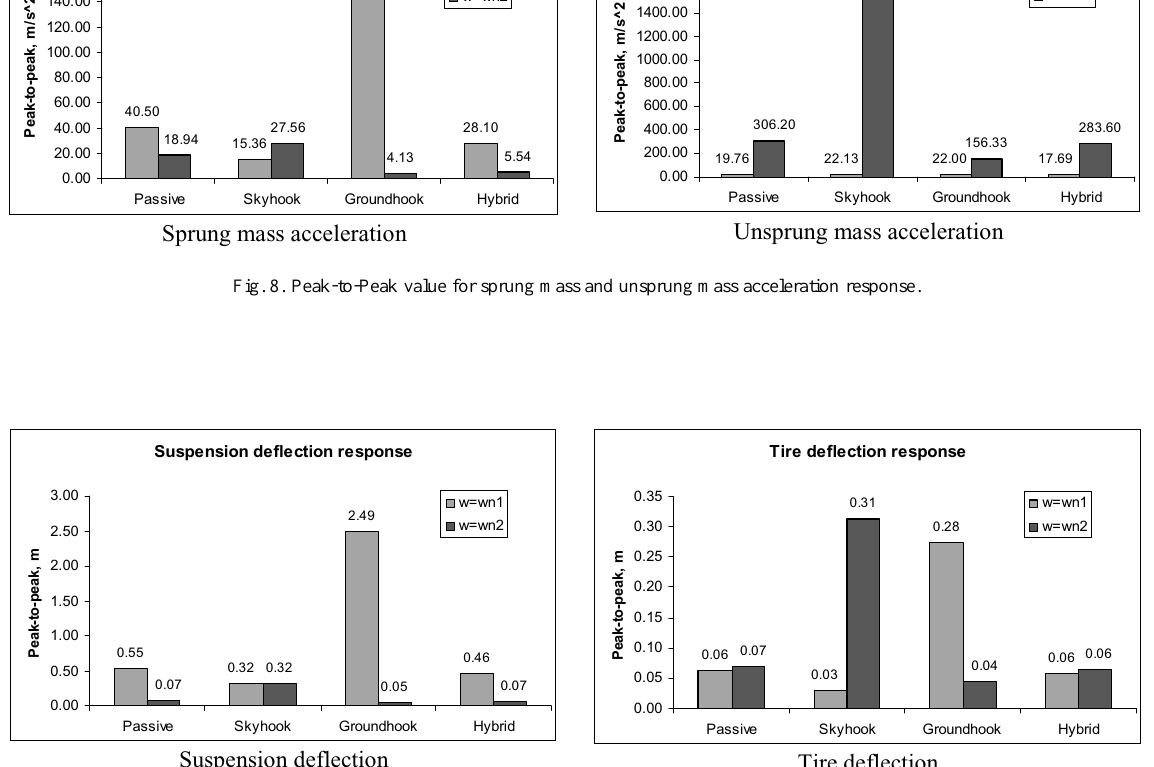
Fig. 9. Peak-to-Peak value for suspension and tire deflection